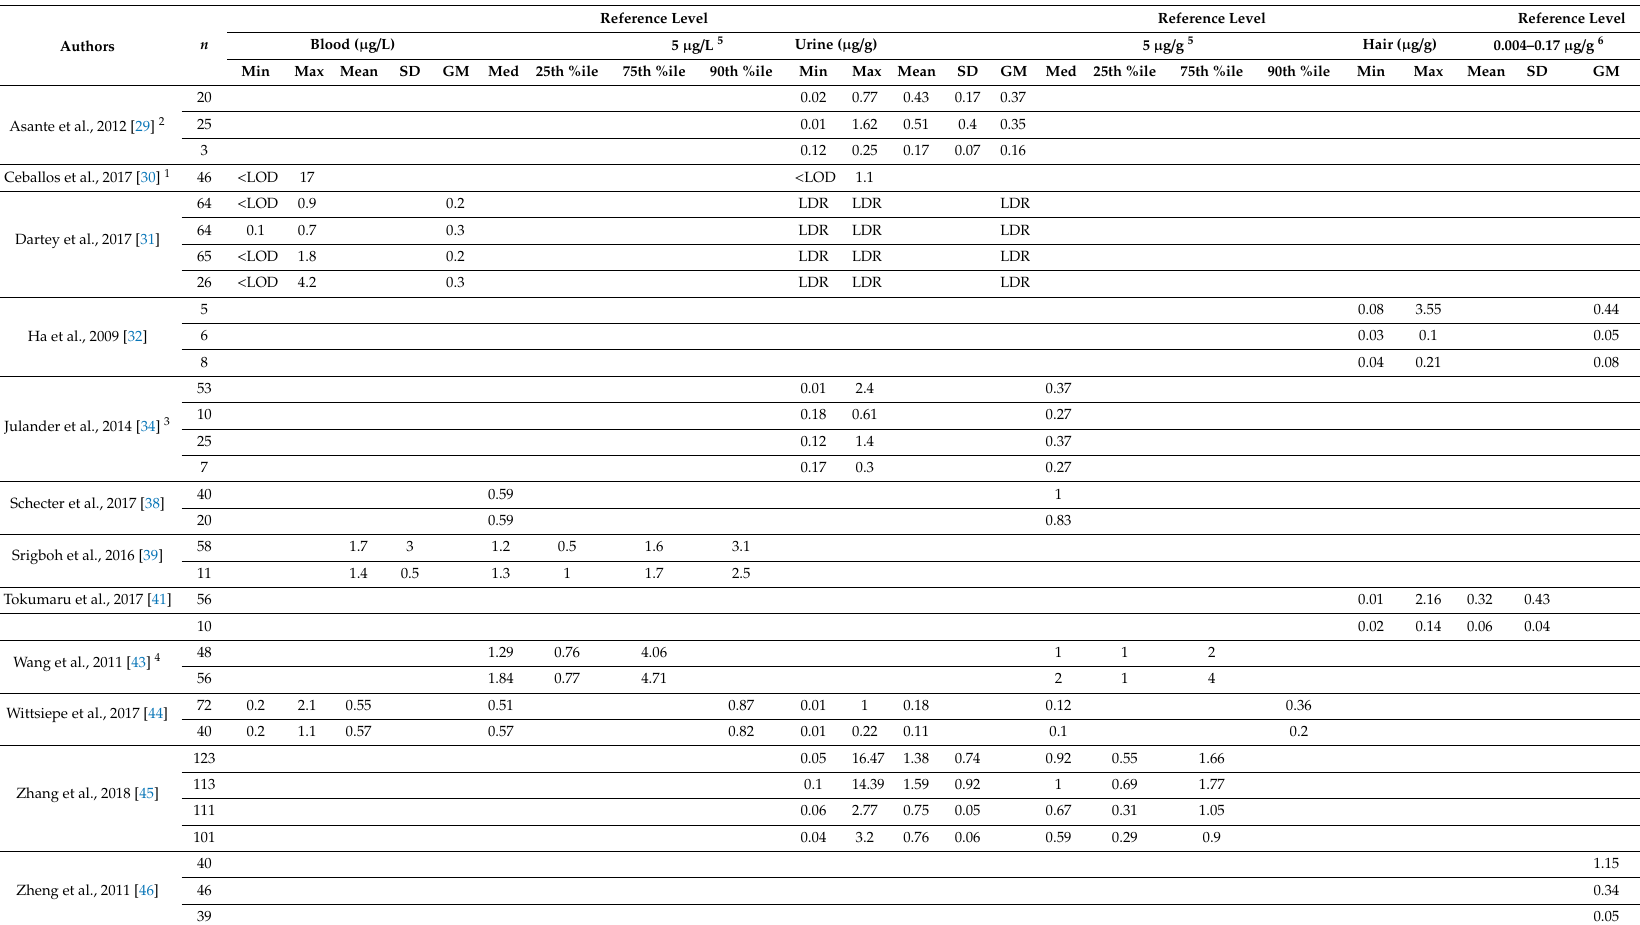
Table 5. Results of data extraction from study set for Cd biomarkers in blood, urine, and hair.